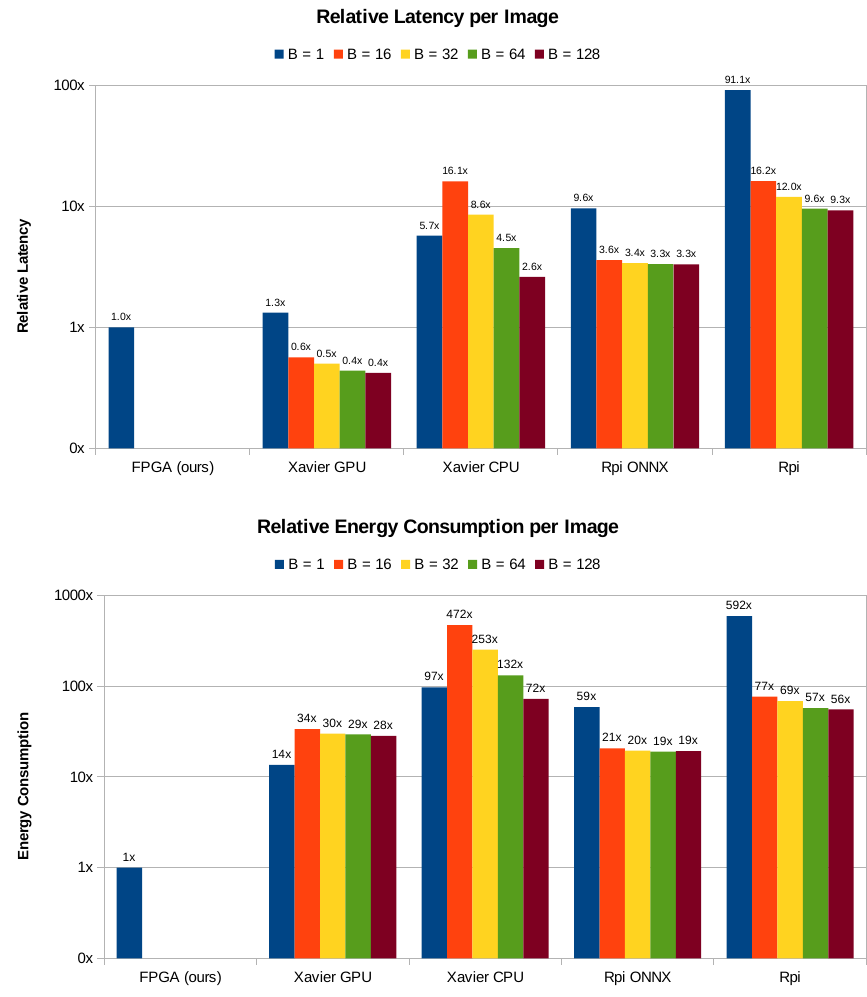
Figure 11. Relative latency and energy consumption per image for different embedded platforms and batch sizes; FPGA, Xavier GPU, Xavier CPU, Rpi and Rpi ONNX stand for our Xilinx UltraScale+ FPGA, Jetson Xavier embedded GPU, Jetson Xavier embedded CPU, Raspberry Pi 3B+ simple CPU and Raspberry Pi 3B+ ONNX-Runtime-based CPU implementations, respectively. The number above each column represents the relative latency or energy consumption with respect to our FPGA implementation.